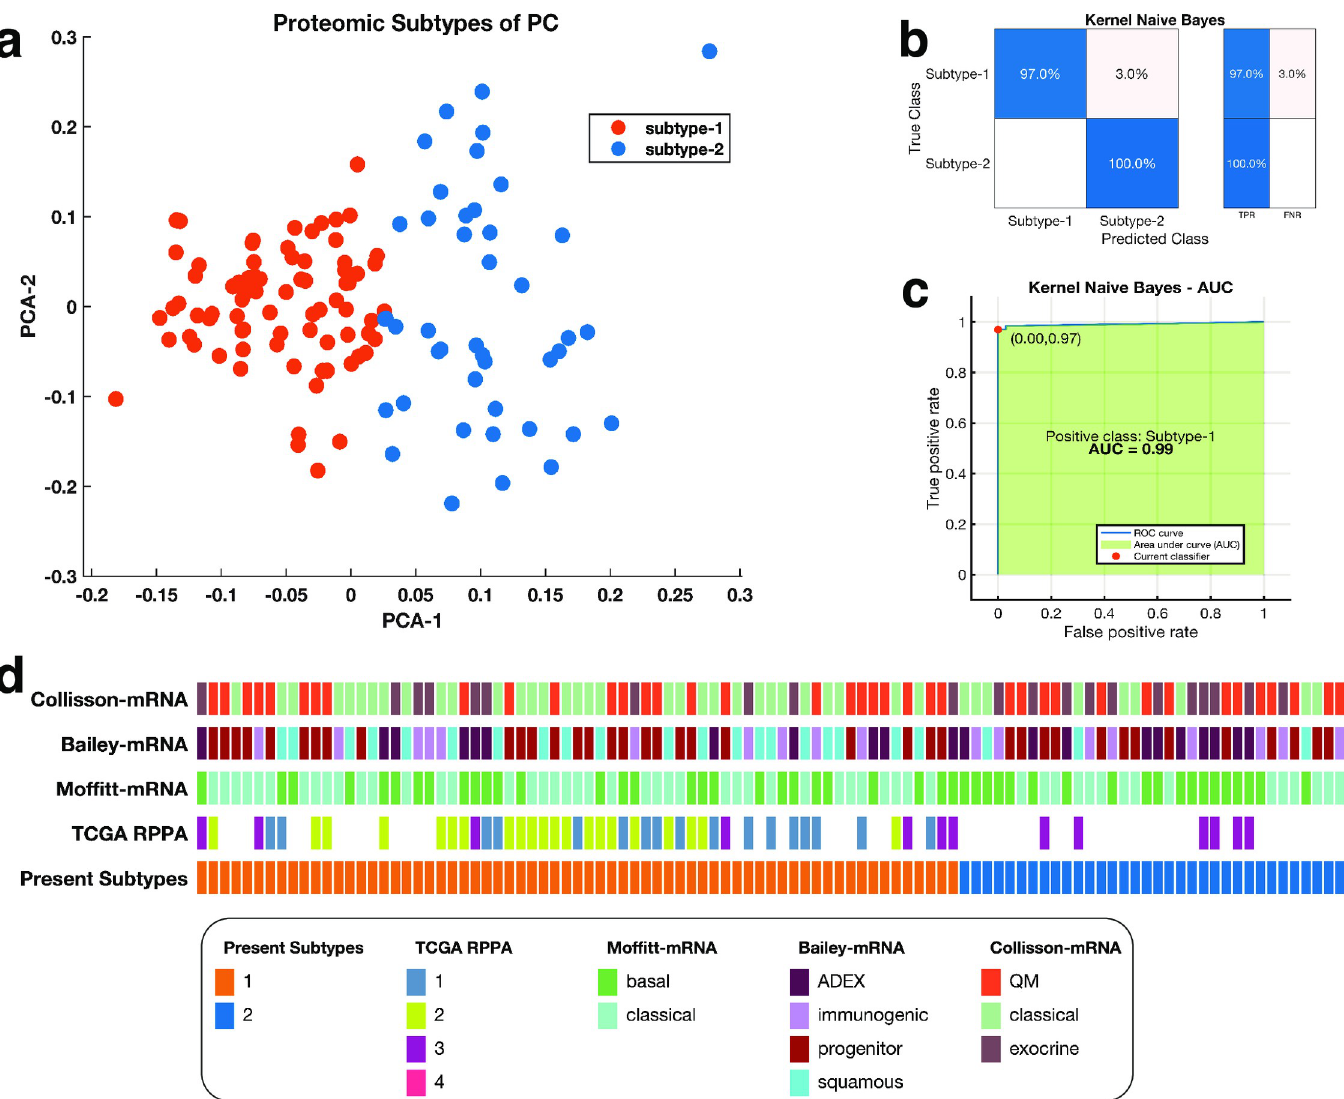
Fig 1. (a) Clustering of pancreatic tumours; the first and second principal components of a PCA analysis are plots on the x-axis and y-axis response. The points are coloured according to the K-mean clustering defined cluster assignments. (b) a representative confusion matrix for the Kernel na ï ve Bayes classifier used to validate the clustering of the proteomic subtypes of pancreatic cancer. The blue cells correspond to samples that are correctly classified. The red cells correspond to incorrectly classified samples. In the plot, TFR shows the true-positive rate and TNR indicate the false-negative rate. (c) the Receiver operating characteristic Curve for the Kernel na ï ve Bayes. The green shaded area represents the area under the curve (AUC = 0.99). (d) Comparison between the current proteomic based classification of pancreatic cancers to other classification schemes from top to bottom: mRNA-based classification schemes established by Collisson et al.; Bailey et al.; and Moffitt et al., and the TCGA’s [23] RPPA classification